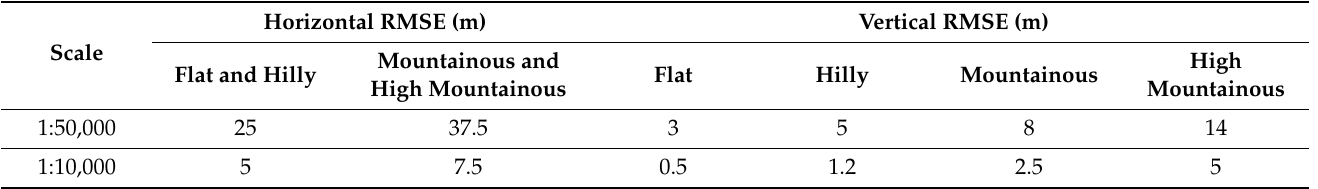
Table 3. Accuracy requirements for 1:50,000 and 1:10,000 scale mapping in China.